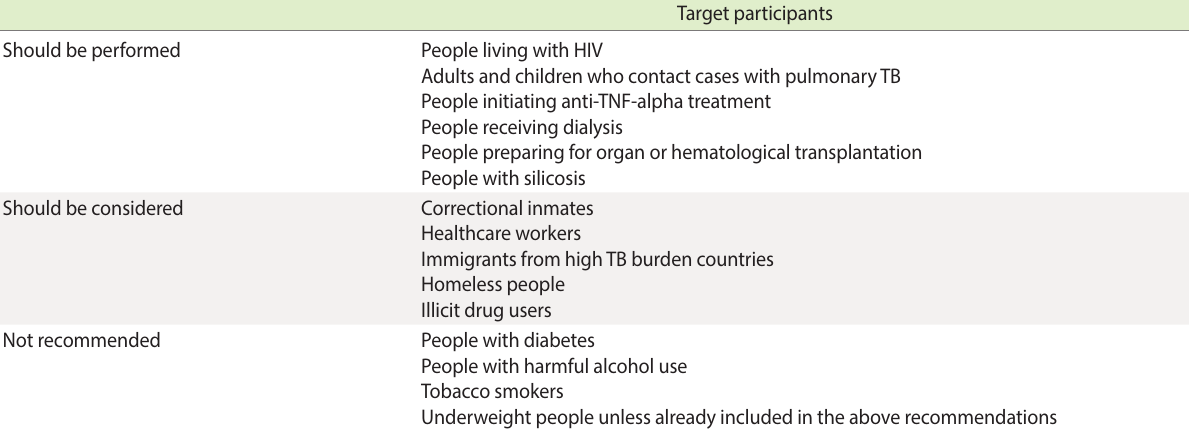
Table 1. Target participants in screening and treatment for latent tuberculosis infection